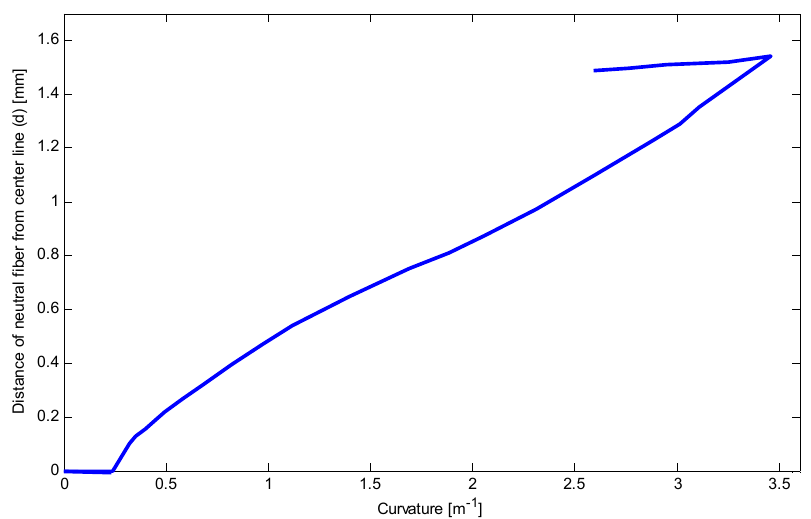
Figure 27. Relationship between curvature and distance of neutral fiber from the centerline during loading and unloading.